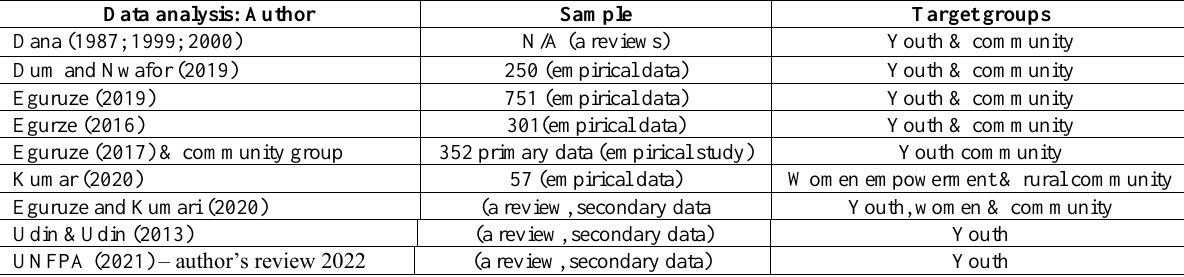
Table 1. Showing an Analysis of Cross-Case Study of Previous Relevant Studies